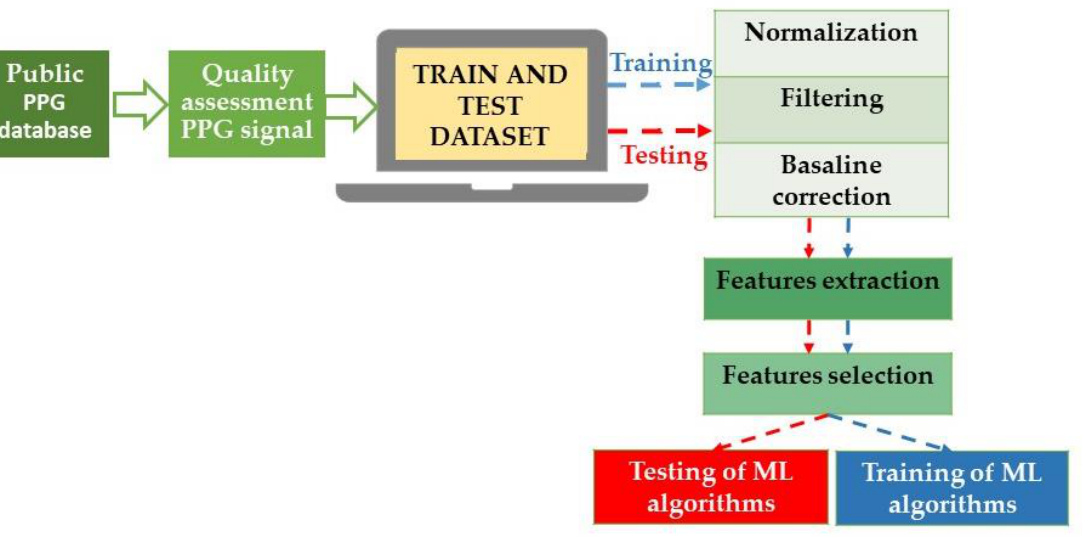
Figure 2. Block diagram of the blood pressure estimation process using ML techniques. In detail, the raw signals are prepared through normalization, the correction of baseline wandering due to respiration, and finally, signal filtration. Specifically, to construct a dataset for BP estimation models, it is necessary to accurately extract the features of the original waveform (and underlying demographic and statistical data) and select effective features, improving the generalization and reducing the risk of overfitting the algorithms. PPG: photoplethysmograph; ML: machine learning .